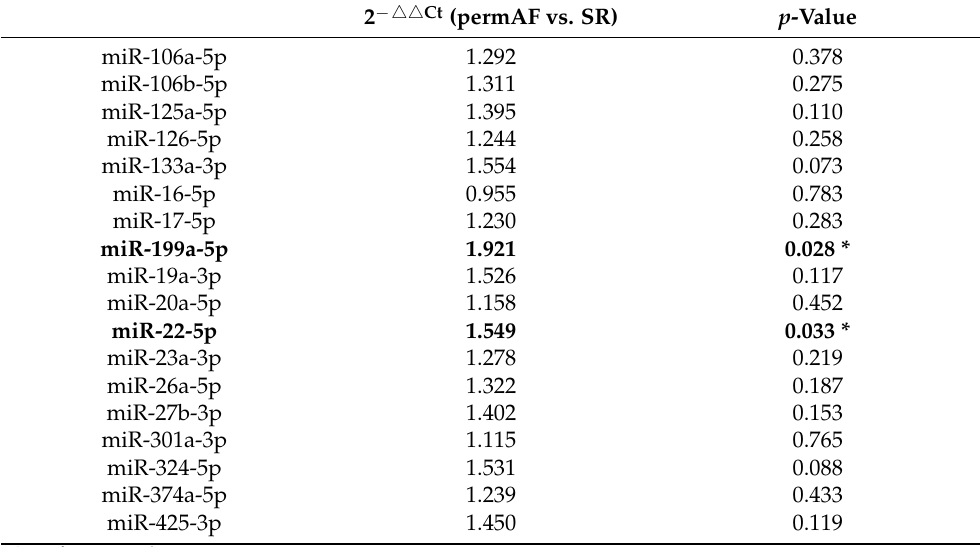
Table 2. Results of the replication study.